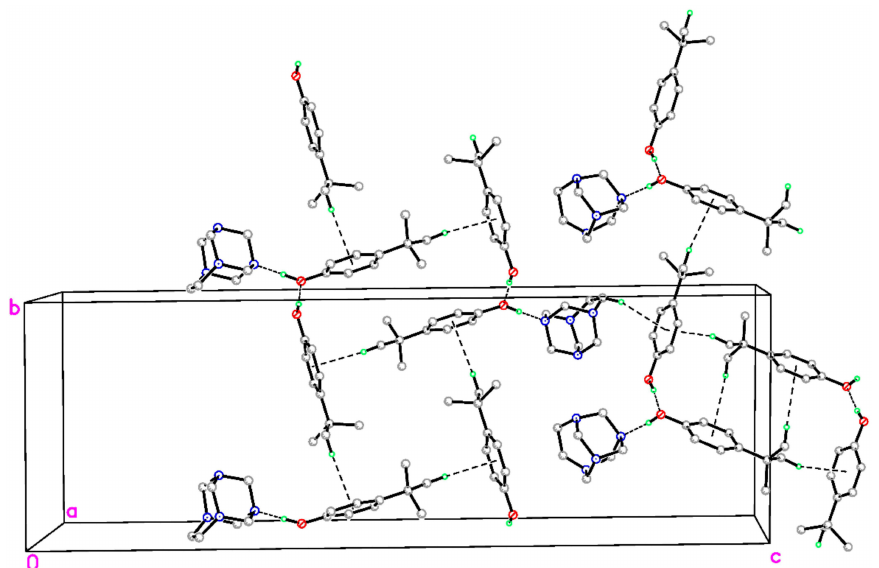
Figure 4. A packing diagram of the title compound showing the C–H ··· Cg interactions as green dashed lines (Symmetry codes: see Table